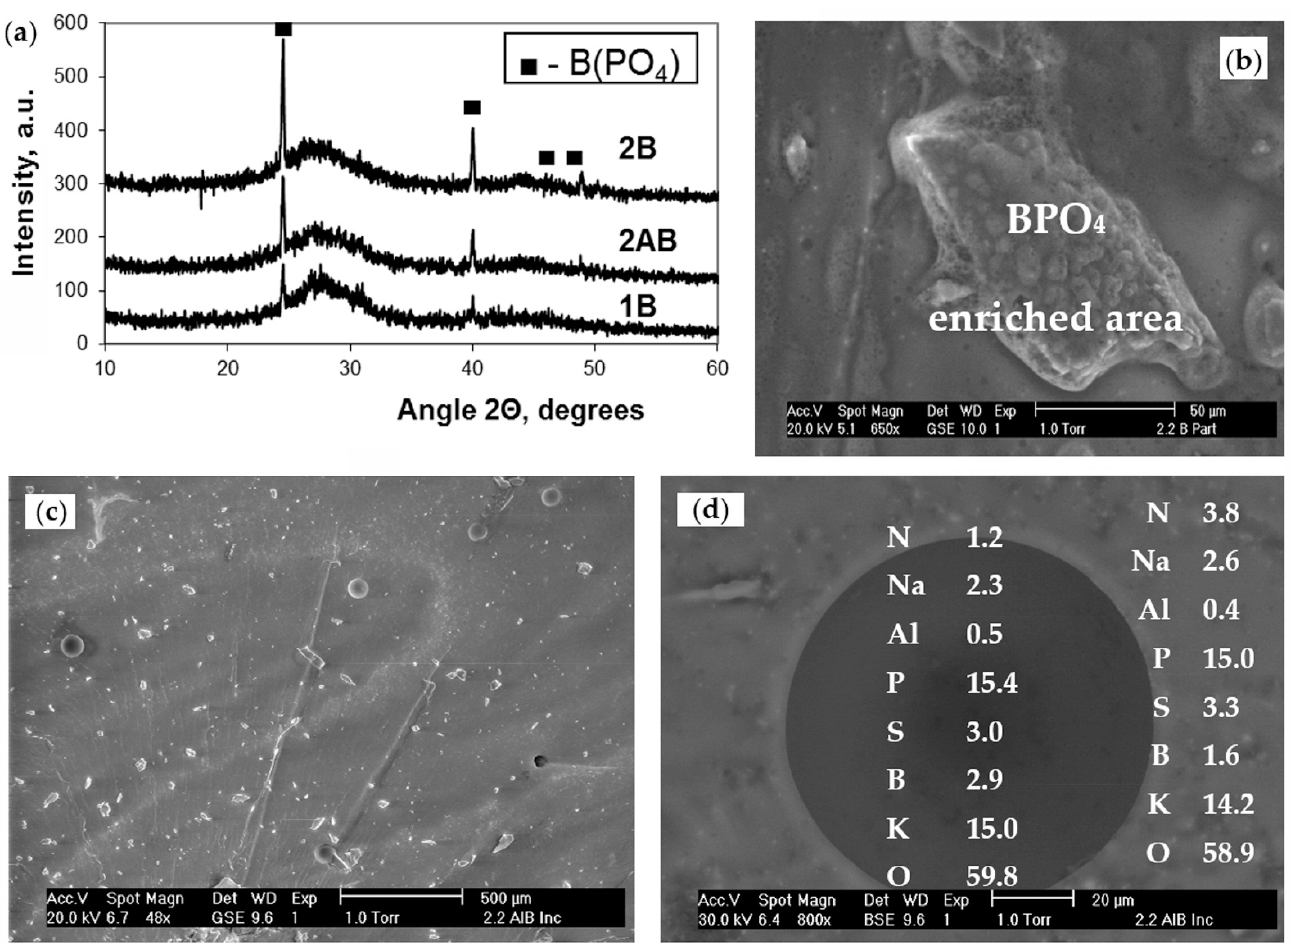
Figure 2. XRD patterns of the glasses 1B, 2B, and 1AB ( a ) and electron images of their structure: 2B ( b ) and 1AB ( c , d ). The chemical composition of the vitreous phases (droplet and matrix) is reported in accordance with the data from the low-energy EDS analysis (without hydrogen).